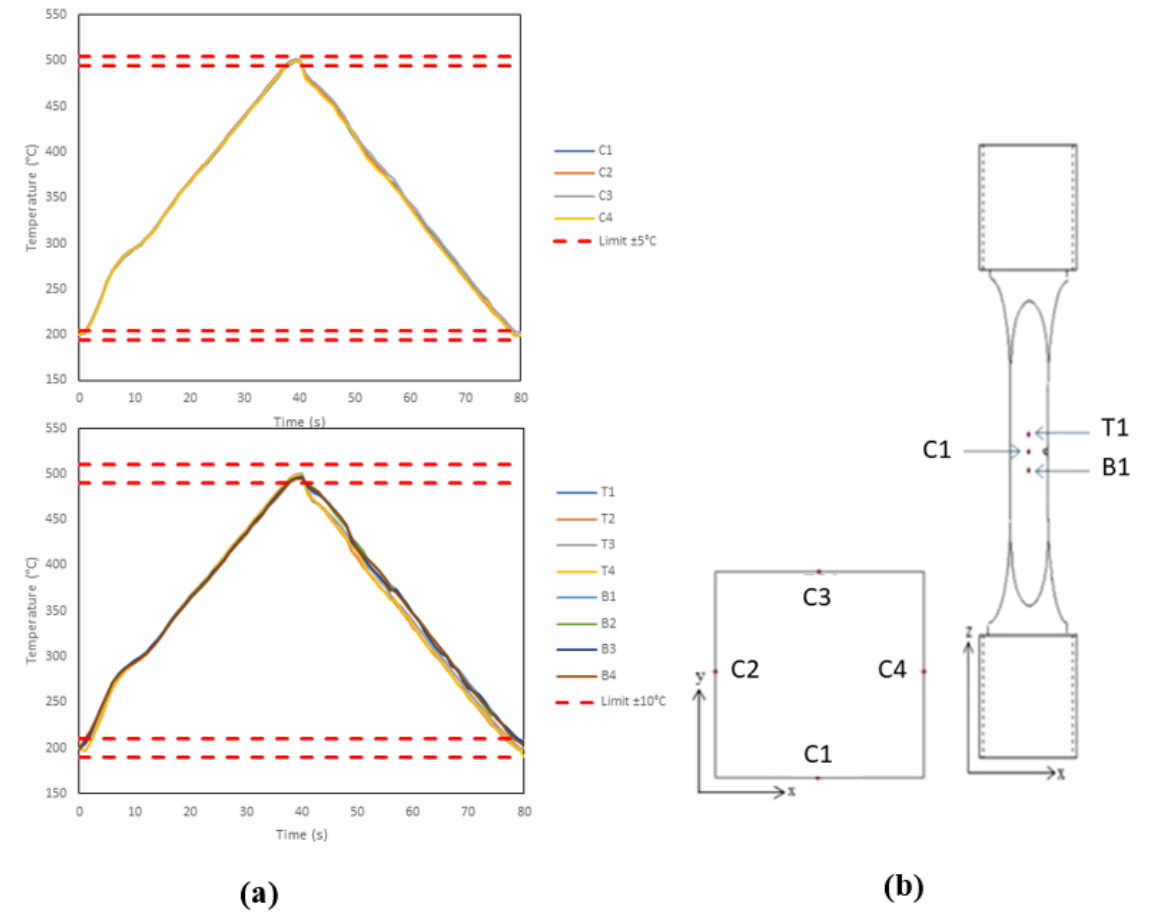
Figure 6. ( a ) Thermal profile achieved for triangular waveform to be used during the test pro- gramme and ( b ) thermocouple (TC) location. and ( b ) thermocouple (TC)